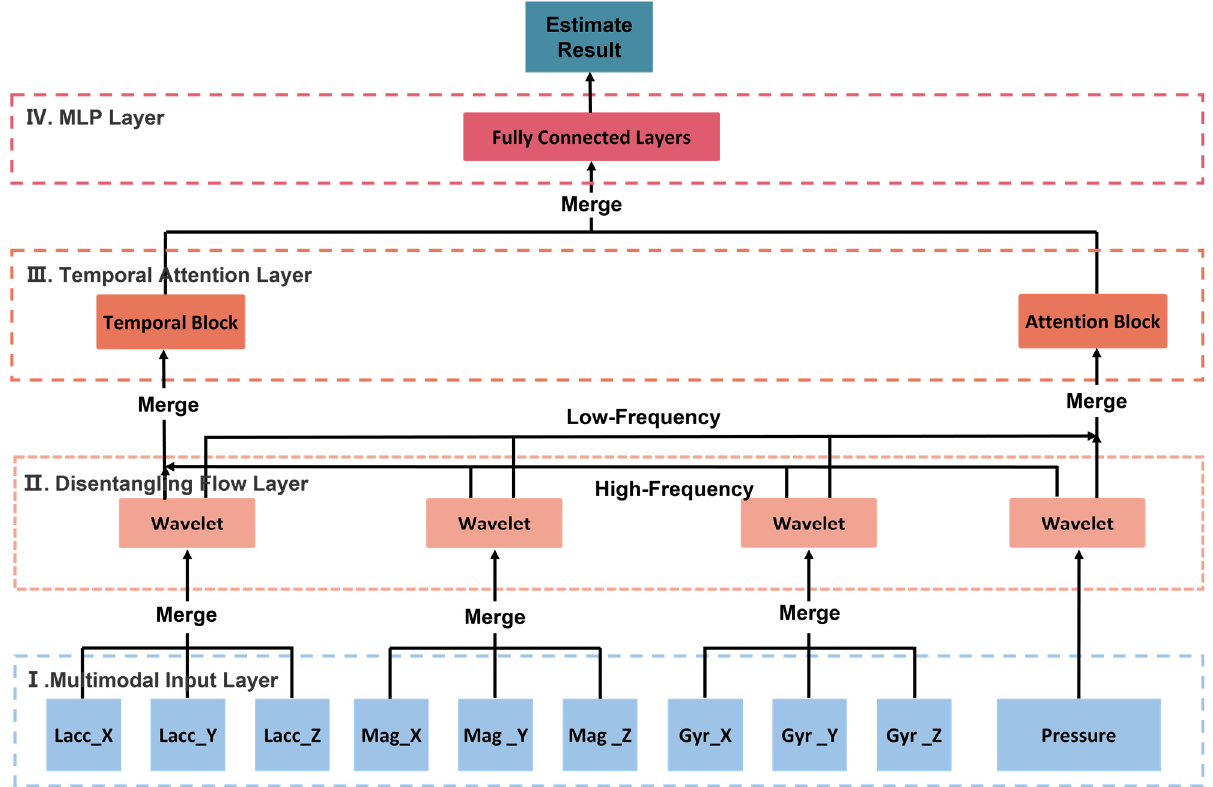
Figure 1. Overall overview diagram of our proposed DFTrans model. The pre-processed sensor acquisition data enters the DFTrans from the Multimodal Input Layer and enters the Disentangling Flow Layer for the separation of high-frequency and low-frequency components, respectively. The high-frequency components are processed in the Temporal Block, and the low-frequency components are processed in the Attention Block. Finally, it is processed by the MLP layer, and the classification results are output.